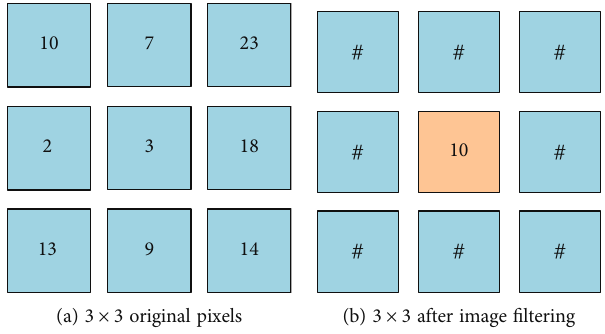
Figure 1: Schematic diagram of how the median denoising algorithm works.